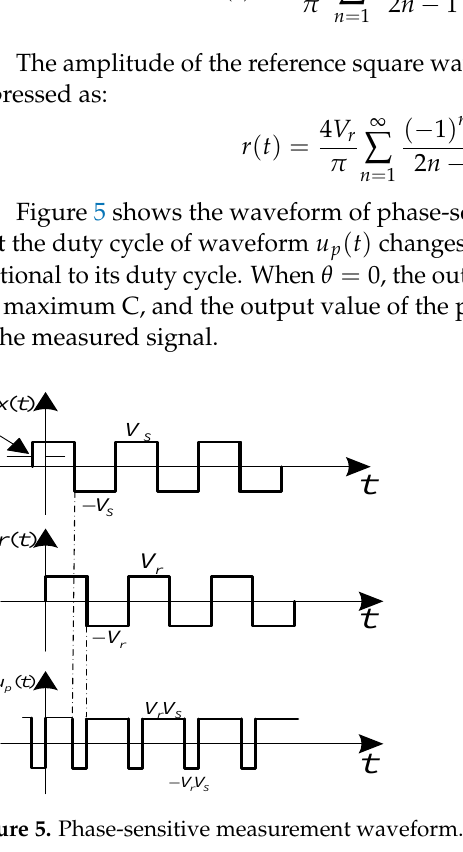
Figure 4. Structure diagram of a lock-in amplifier.